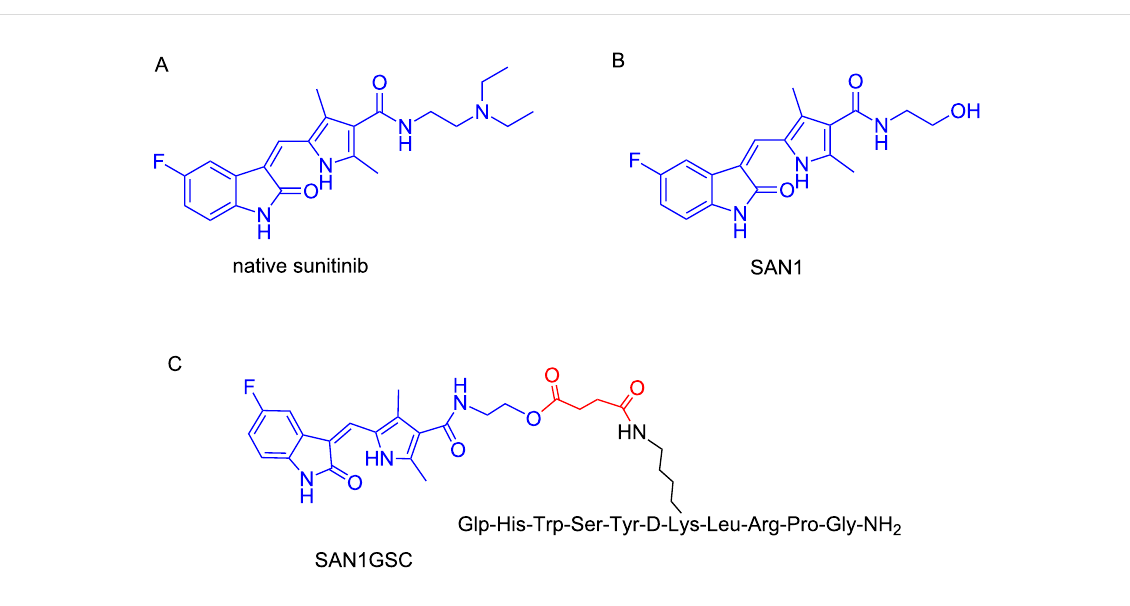
tive to the parent drug for the formulation of the final PDC.